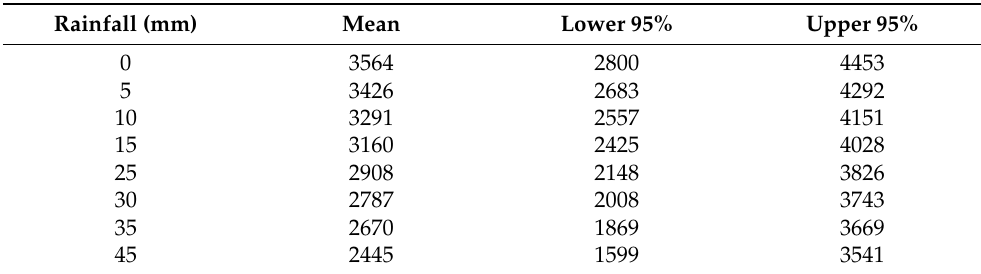
Table 3. Summary of predicted daily distance moved (m) at different levels of rainfall and 95% confidence